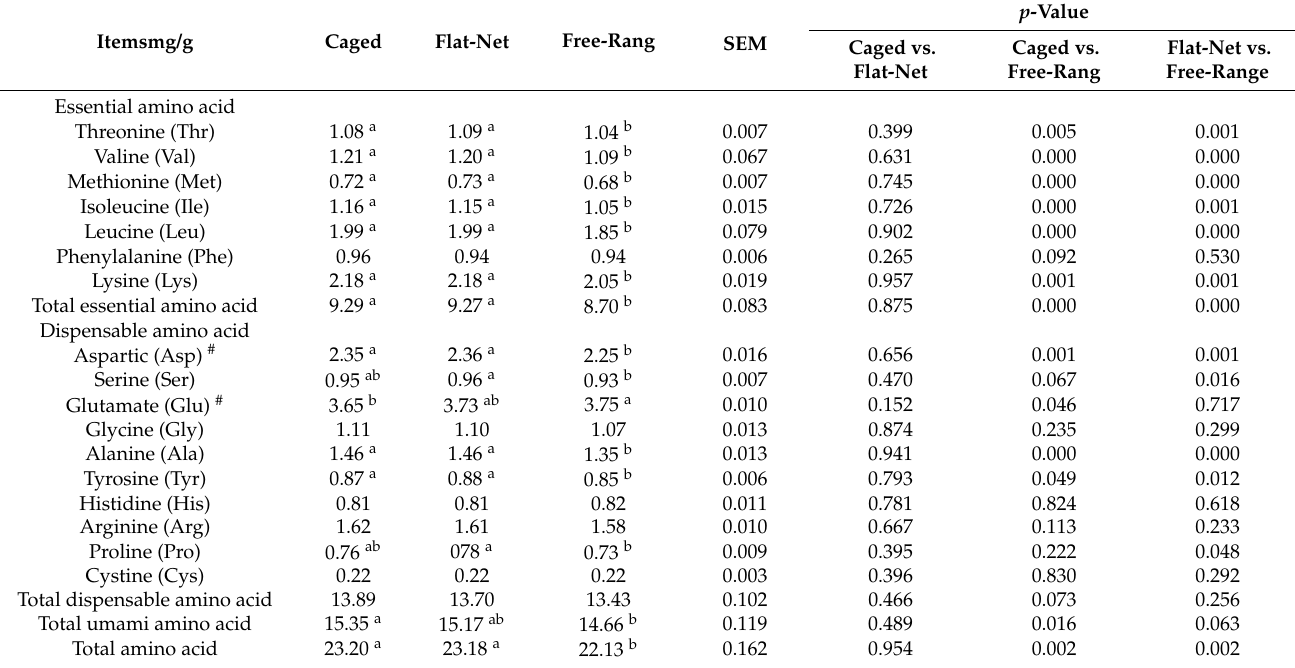
Table 3. AA measured under three rearing systems of Lueyang black-bone chickens.